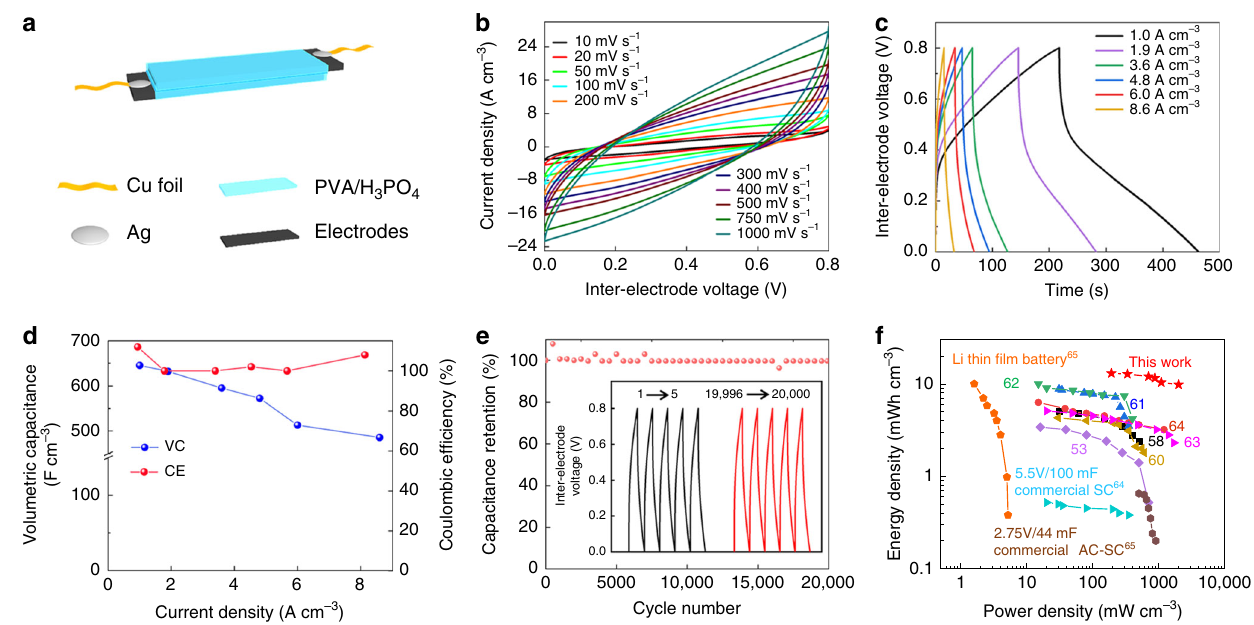
Fig. 4 Electrochemical characterization of the supercapacitor. a Illustration of the components of a fl exible supercapacitor based on MrGO-AD sheets. b Cyclic voltammetry (CV) curves at scan rates of 10 to 1000 mV s − 1 for the MrGO-AD supercapacitor. c GCD curves for the MrGO-AD sheet supercapacitor. d Volumetric capacitance of the MrGO-AD sheet supercapacitor for current densities from 1.0 to 8.6 A cm − 3 . e Capacitance retention during the cycling of a MrGO-AD supercapacitor. f Volumetric energy density and power density of the MrGO-AD supercapacitor compared with alternative energy storage